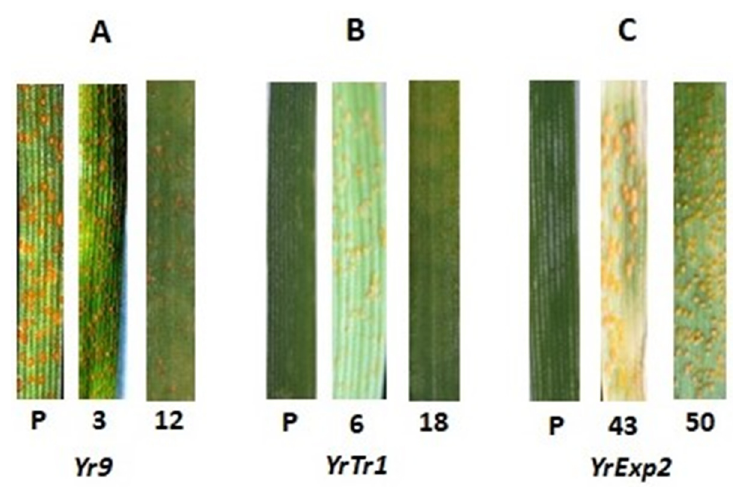
Figure 1. Infection types (ITs) scale bar: 0–9 produced by the parental isolate (P), [Pak-1-(A)-9] of a Pakistani dominant race (574232) of Puccinia striiformis f. sp. tritici ( PST ) selfed on Berberis pseudumbellata , and its progeny isolates (3, 12, 6, 18, 43, and 50) on wheat Yr single-gene lines ( A ) Yr9 ; ( B ) YrTr1 , and ( C ) YrExp2 . Table 1. Virulence phenotypes (VPs) of the parental and one hundred and fifteen progeny isolates of dominant Pakistani race (574232) of Puccinia striiformis f. sp. tritici ( PST ) on 24 wheat Yr single-gene lines.